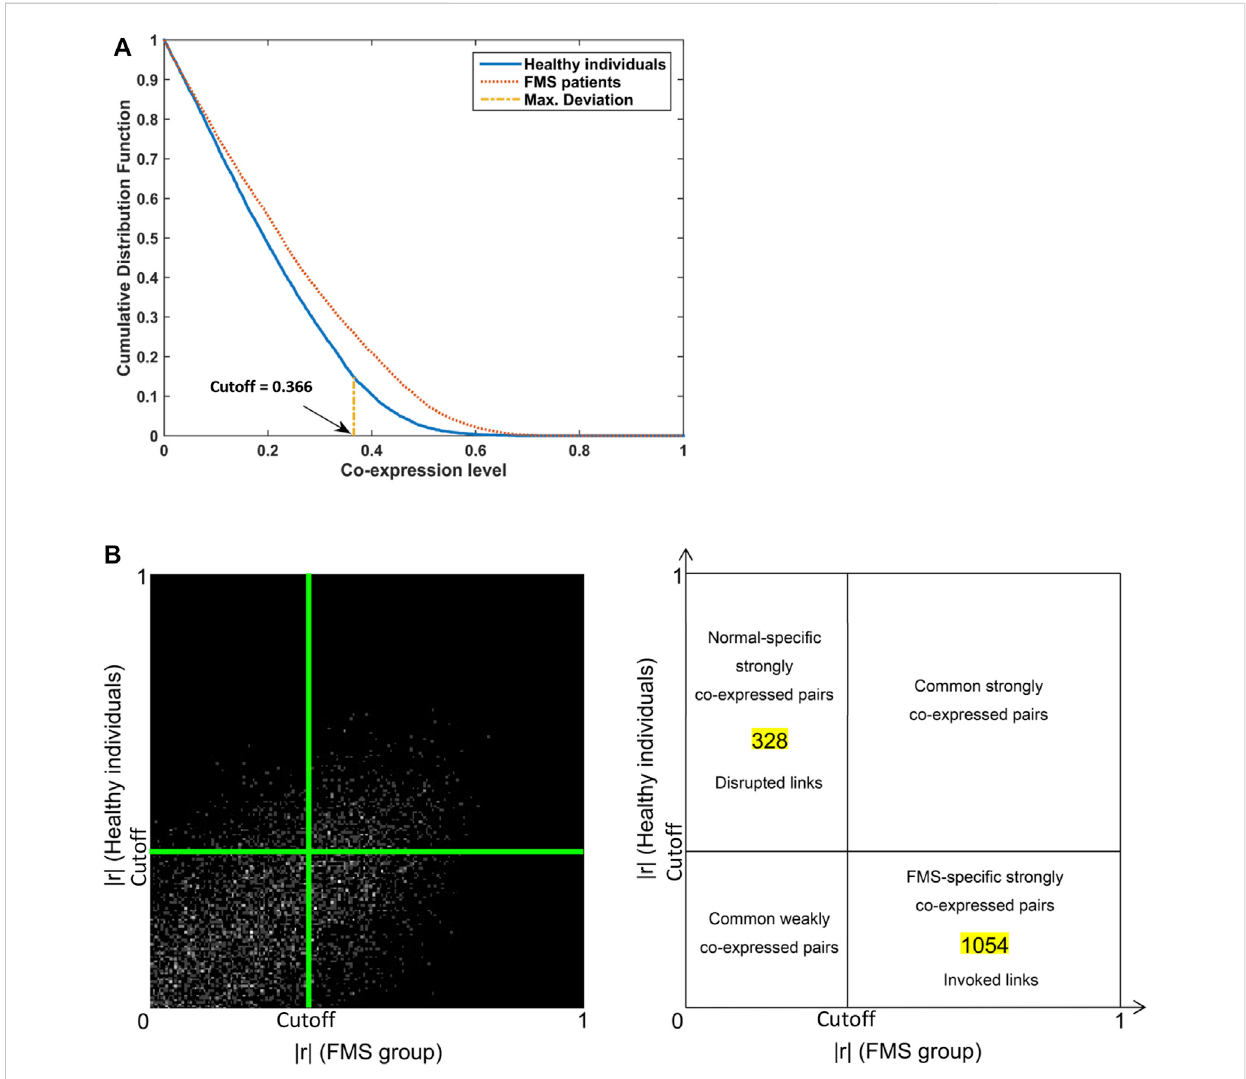
FIGURE 2 Co-expression patterns for genes involved in pain signaling pathway. (A) Cumulative distribution plots in the FMS and healthy individuals. The FMS- speci fi ccutoff point 0.366 wasidenti fi ed. (B) Co-expressiongalaxy (left)andfourregions (right) partitioned bythecutoff point. Eachabsolutecorrelation coef fi cient (|r|) was represented by one white dot in the galaxy. More dots demonstrated that more correlation coef fi cients located in that region. FMS, Fibromyalgia